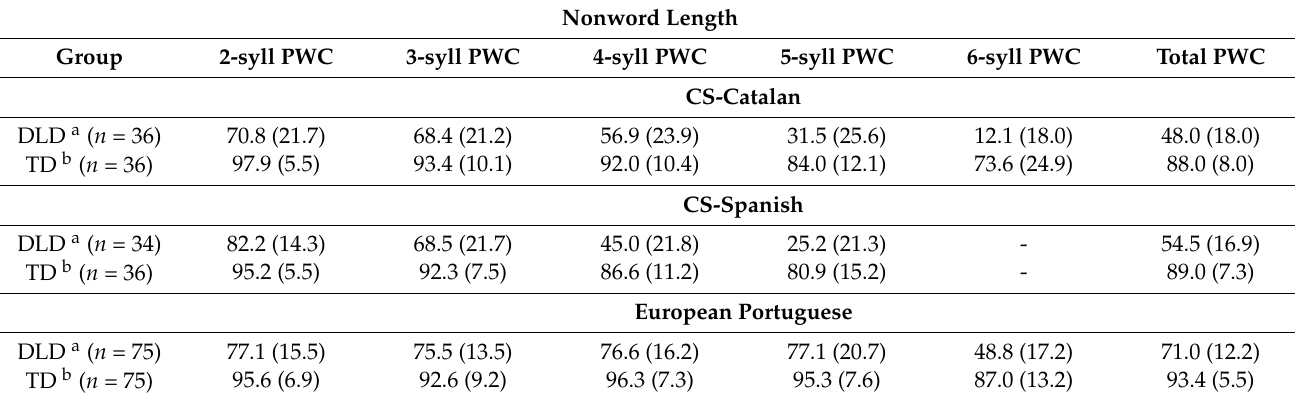
Table 4. Means and standard deviations on the NRT task for percentage of words correct (PWC) overall and for each syllable length for the Catalan and Spanish versions of the NRT for the Catalan–Spanish (CS) and European Portuguese (EP) children with developmental language disorder (DLD) and typically developing (TD)